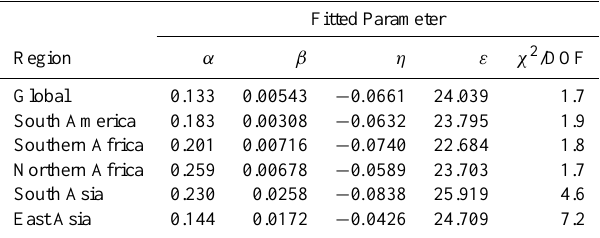
Table 1. Values of the empirical fitting parameters in Eq. (4) for various regions. The least-square fits are computed using IWC (mgm − 3 ) measured by MLS, and r e (µm) and AOT measured by MODIS from August 2004 to July 2008. The convergence of each fit is indicated by χ 2